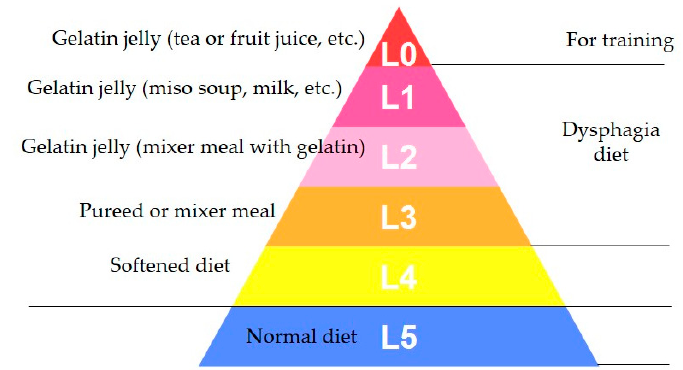
Figure 8. Schema of 5-stage Seirei Dysphagia Diets (Dysphagia Diet Pyramid).